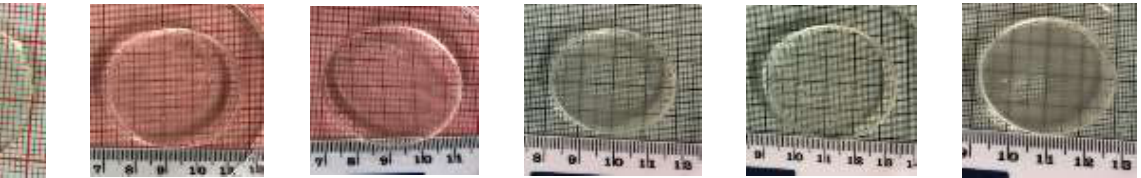
Figure 7. Pulsatile swelling behaviours of chemically crosslinked NVCL/NVP, NVCL/DMAAm, and NVCL/NVP/DMAAm hydrogels with different polymeric compositions and 2 wt% PEGDMA at temperatures between 20 °C and 50 °C.